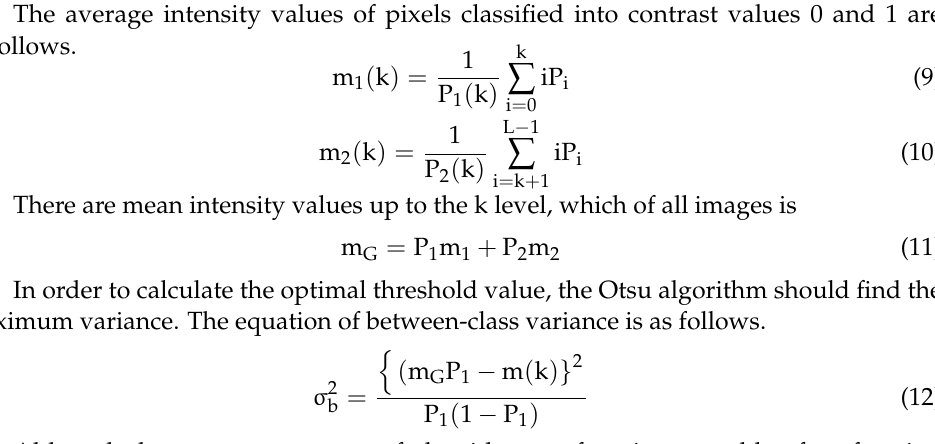
Figure 2. The principle of acquiring binary image by using gray scale-based histogram in the Otsu algorithm.